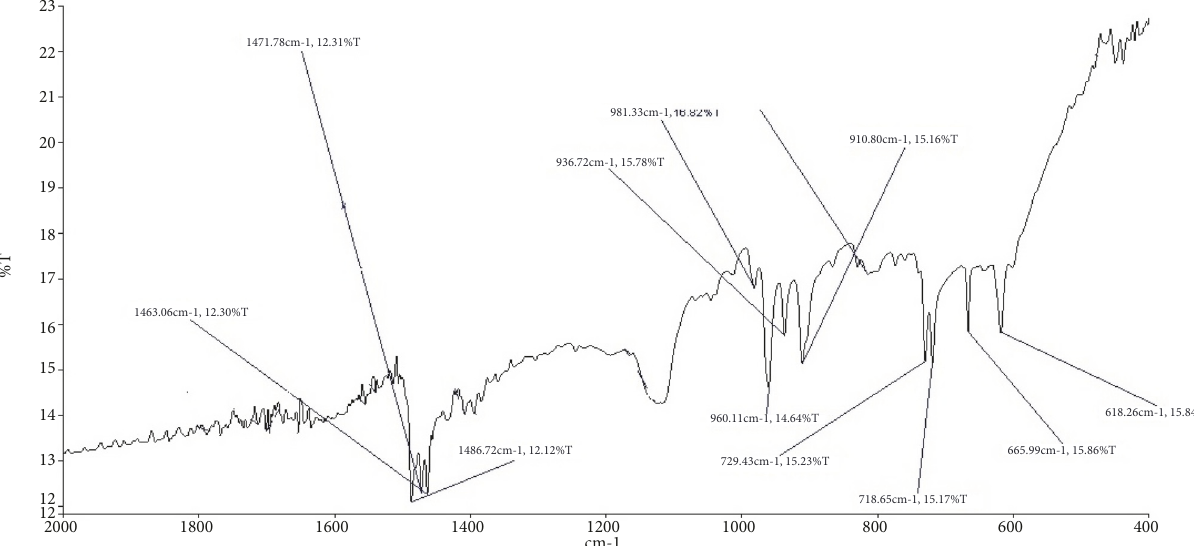
Figure 5: FTIR spectroscopy of surface-modified MWCNTs.